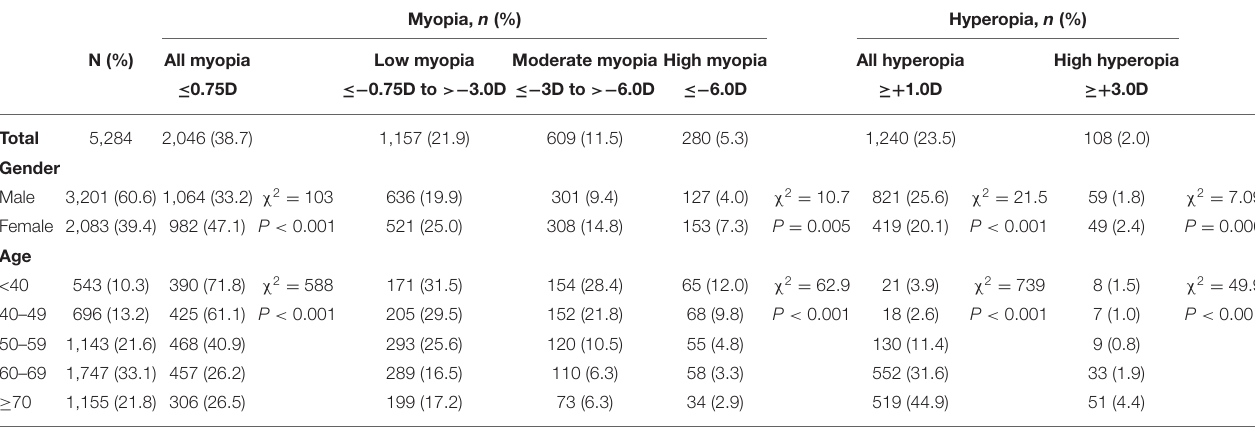
TABLE 1 | Prevalence of refractive error (RE) by the gender and age.